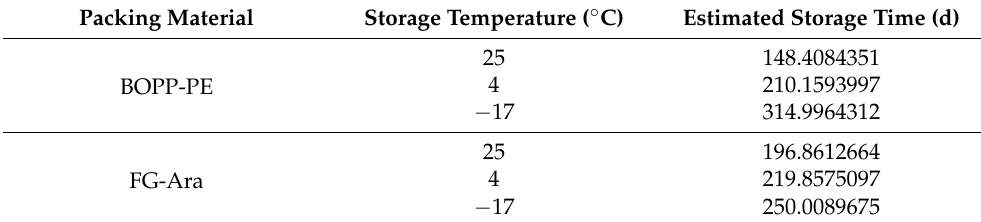
Table 9. Maximum shelf life of different packaging materials. Packing Material Storage Temperature ( ◦